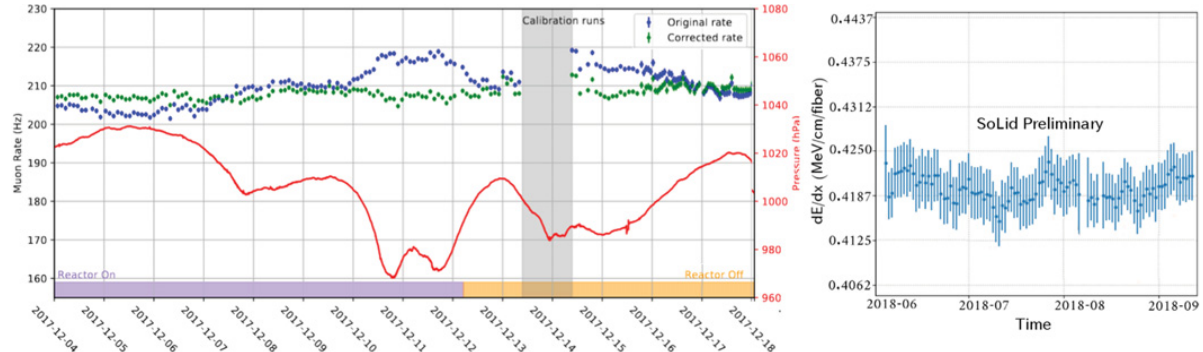
Figure 11. Left : Monitoring of the muon rate during reactor on and off periods, demonstrating accurate muon reconstruction. The correction for pressure variations is shown in green. Right : Monitoring of muon energy deposits.